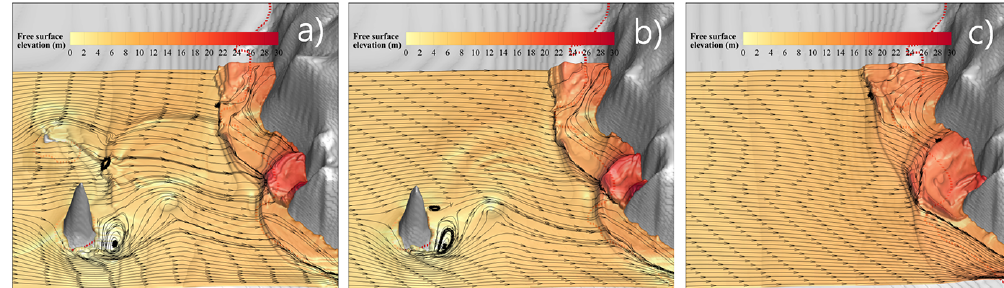
Figure 9. Streaklines in the vicinity of islands computed at t = 240s (a) with two islands, (b) with one island and (c) without islands.